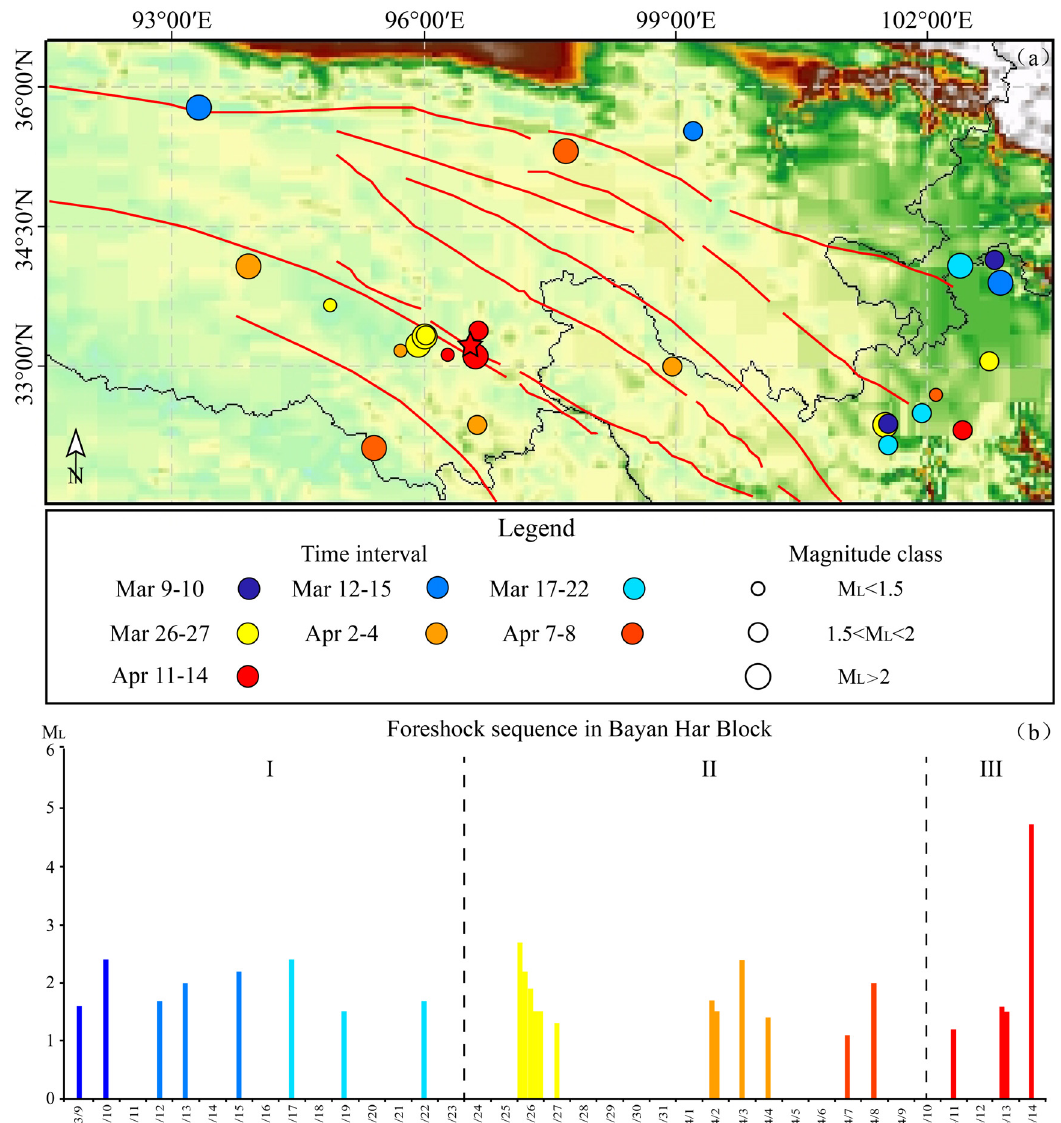
Figure 7. Spatial distribution (a) and temporal sequence (b) of foreshocks in Bayan Har block from March 1 to April 13 (recorded by CENC; http://www.